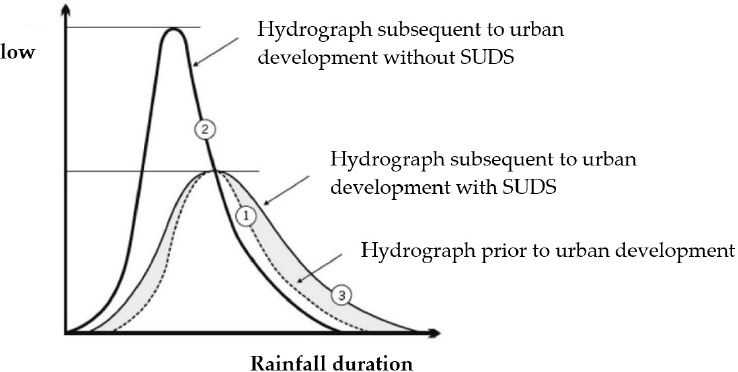
Figure 2. Hydrograph of surface run-off existing in undeveloped land, urbanised without SUDS and after the implementation of SUDS. Own elaboration based on [2] .